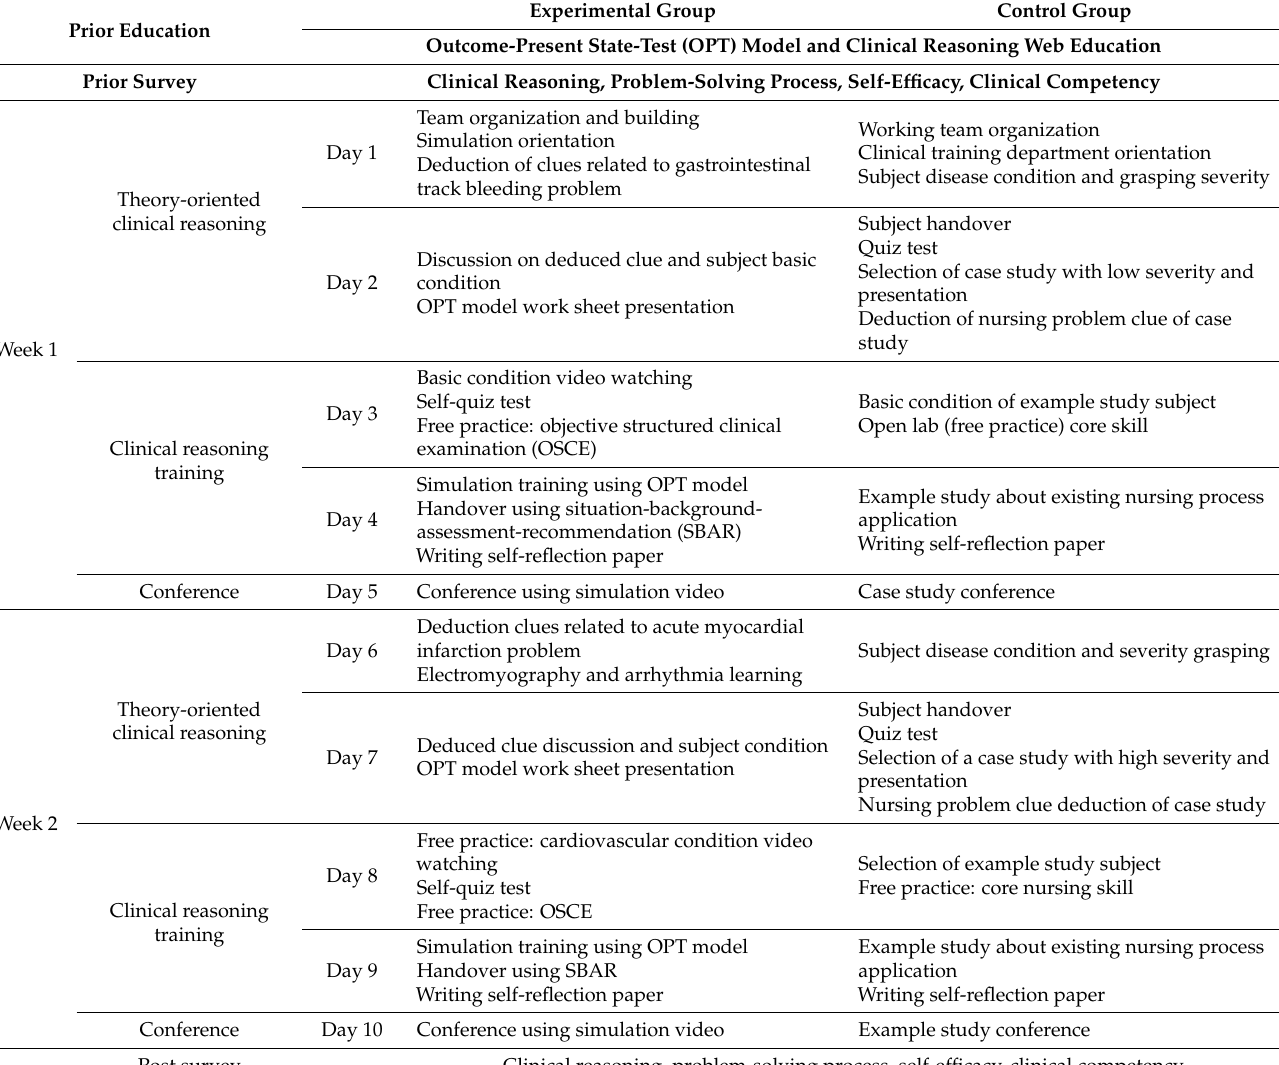
Table 1. The content of the simulation nursing education